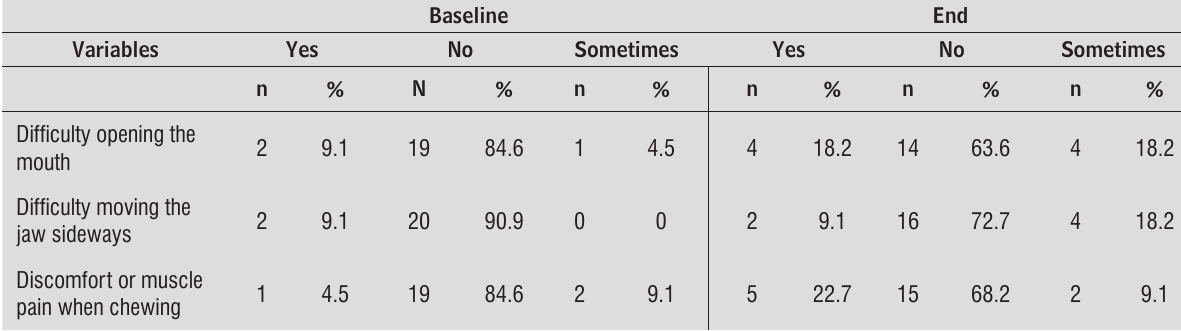
Table 2 - Analysis of the questionnaire to assess the TMD at baseline and at the end of treatment Baseline End Variables